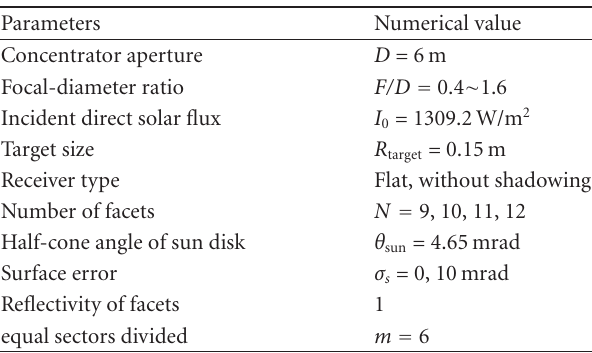
Table 1: Parameters of the simulated concentrator.